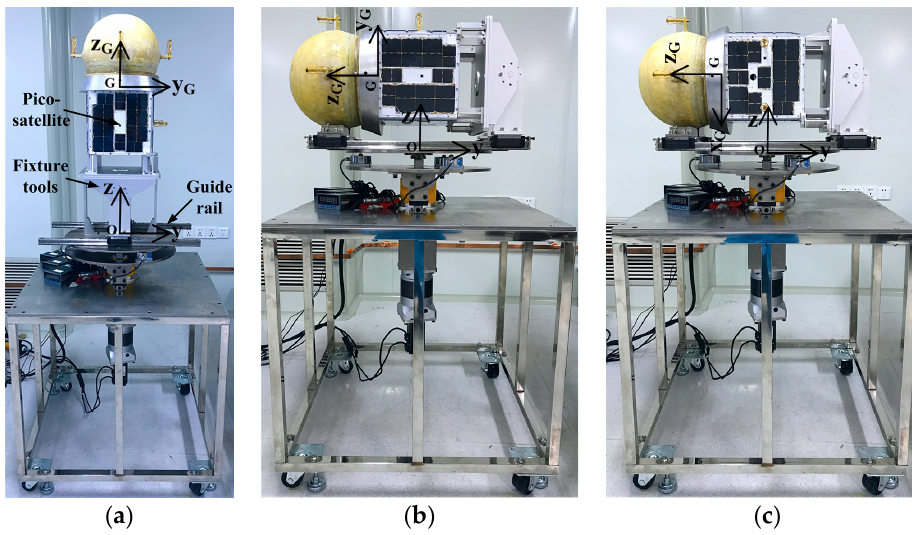
Figure 10. Different measuring states ( a ) pico-satellite vertical position; ( b ) pico-satellite horizontal position- α ; ( c ) pico-satellite horizontal position- β